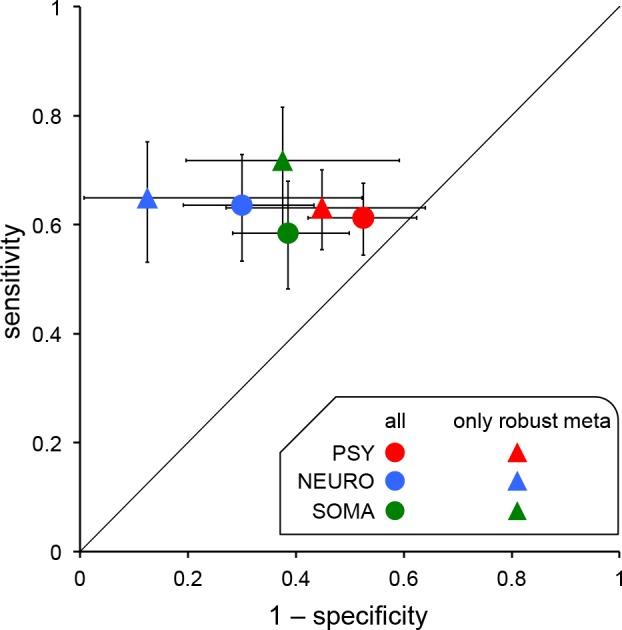
ROC diagram expressing the sensitivity and specificity of initial studies in agreeing with corresponding meta-analyses regarding the presence or absence of a nominally significant effect.For the three biomedical domains the diagram either considered all 663 pairs of initial studies and meta-analyses (circles) or only the 385 initial studies paired with stringent meta-analyses (triangles). Error bars represent the confidence intervals at 95%. The dashed diagonal line corresponds to no discrimination above chance. The fact that errors bars related to psychiatry cross this line suggests that the agreement between initial studies and corresponding meta-analyses might not be better than chance. PSY: psychiatry; NEURO: neurology; SOMA: somatic diseases.